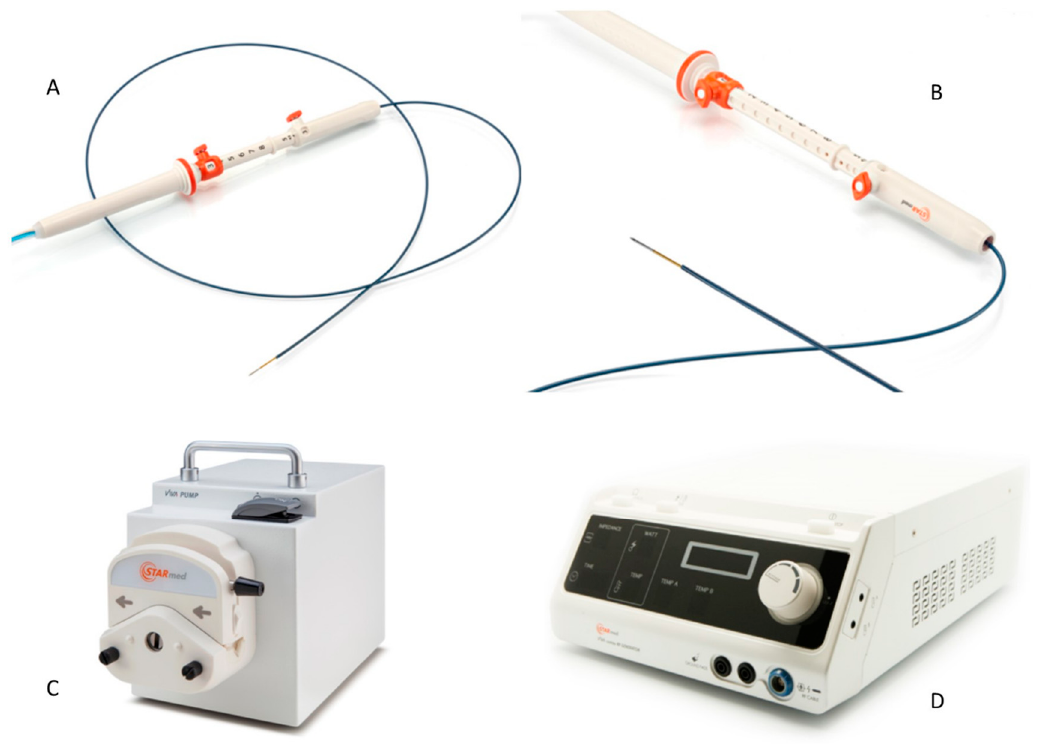
Figure 1. Radiofrequency ablation system (STARMED, Koyang, Korea): ( A , B ) EUSRA needle and tip (active part), available at different sizes and usable under endoscopic ultrasound guide; ( C ) peristaltic pump for needle perfusion with chilled solution during thermal ablation; ( D ) VIVA radiofrequency generator: power can be regulated and time and impedance are continuously monitored during the ablation.